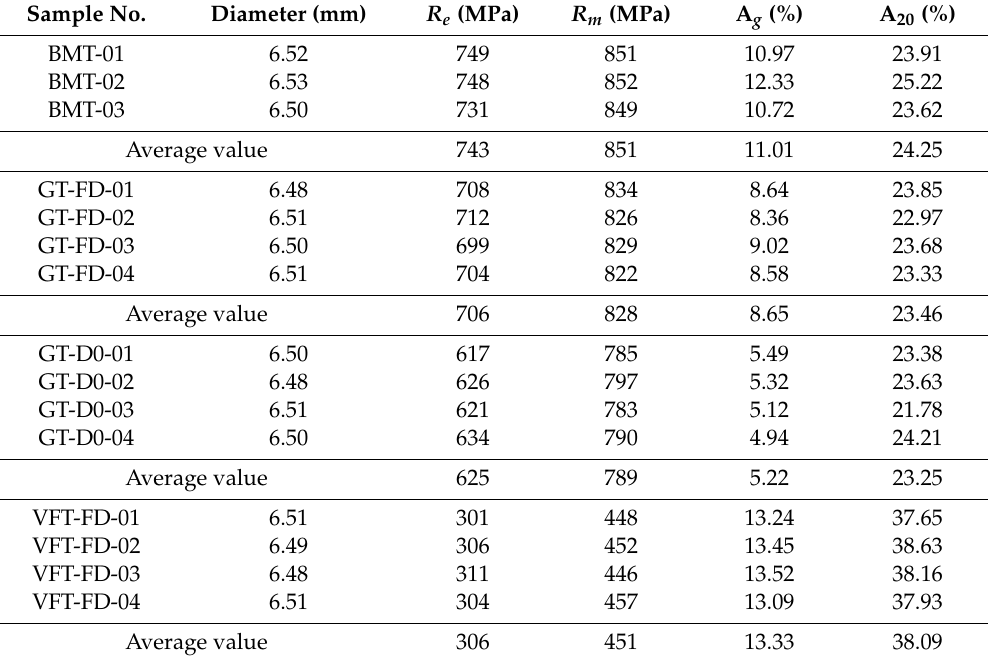
Table 5. Mechanical properties for temperature cycles (temperature 23 ◦ C, strain rate 10 − 2 s − 1 ). Sample